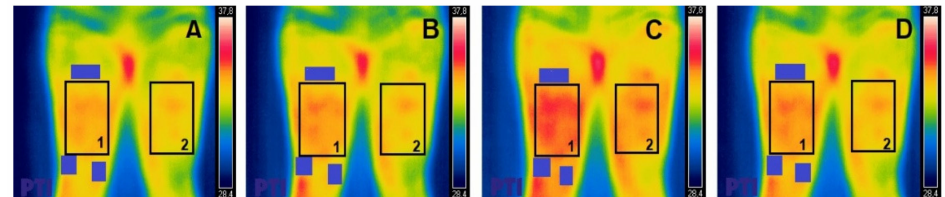
Figure 1. Thermal photography of the anterior region of the thigh (bilateral). Region of interest (ROI) indicated as 1 (leg with electrodes) and 2 (leg without electrodes); electrodes outside the ROI indicated by purple rectangles. ( A ) = Pre; ( B ) = Post0; ( C ) = Post10; ( D ) = Post20. After placement of the electrodes, and prior to the start of the imaging protocol, each subject was given a standardized acclimation time of 10